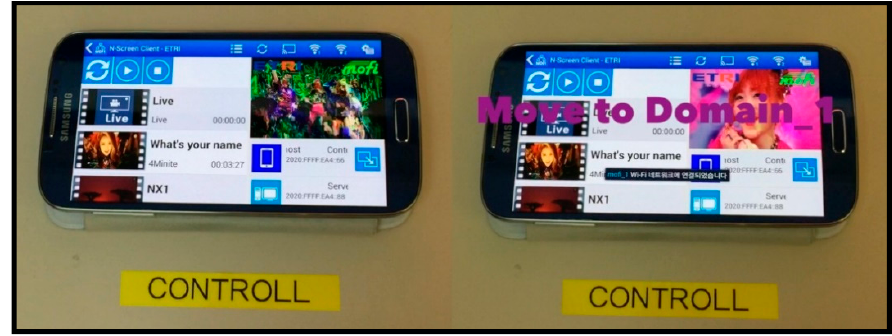
Figure 32. Inter ‐ domain handover scenario. Figure 32. Inter-domain handover